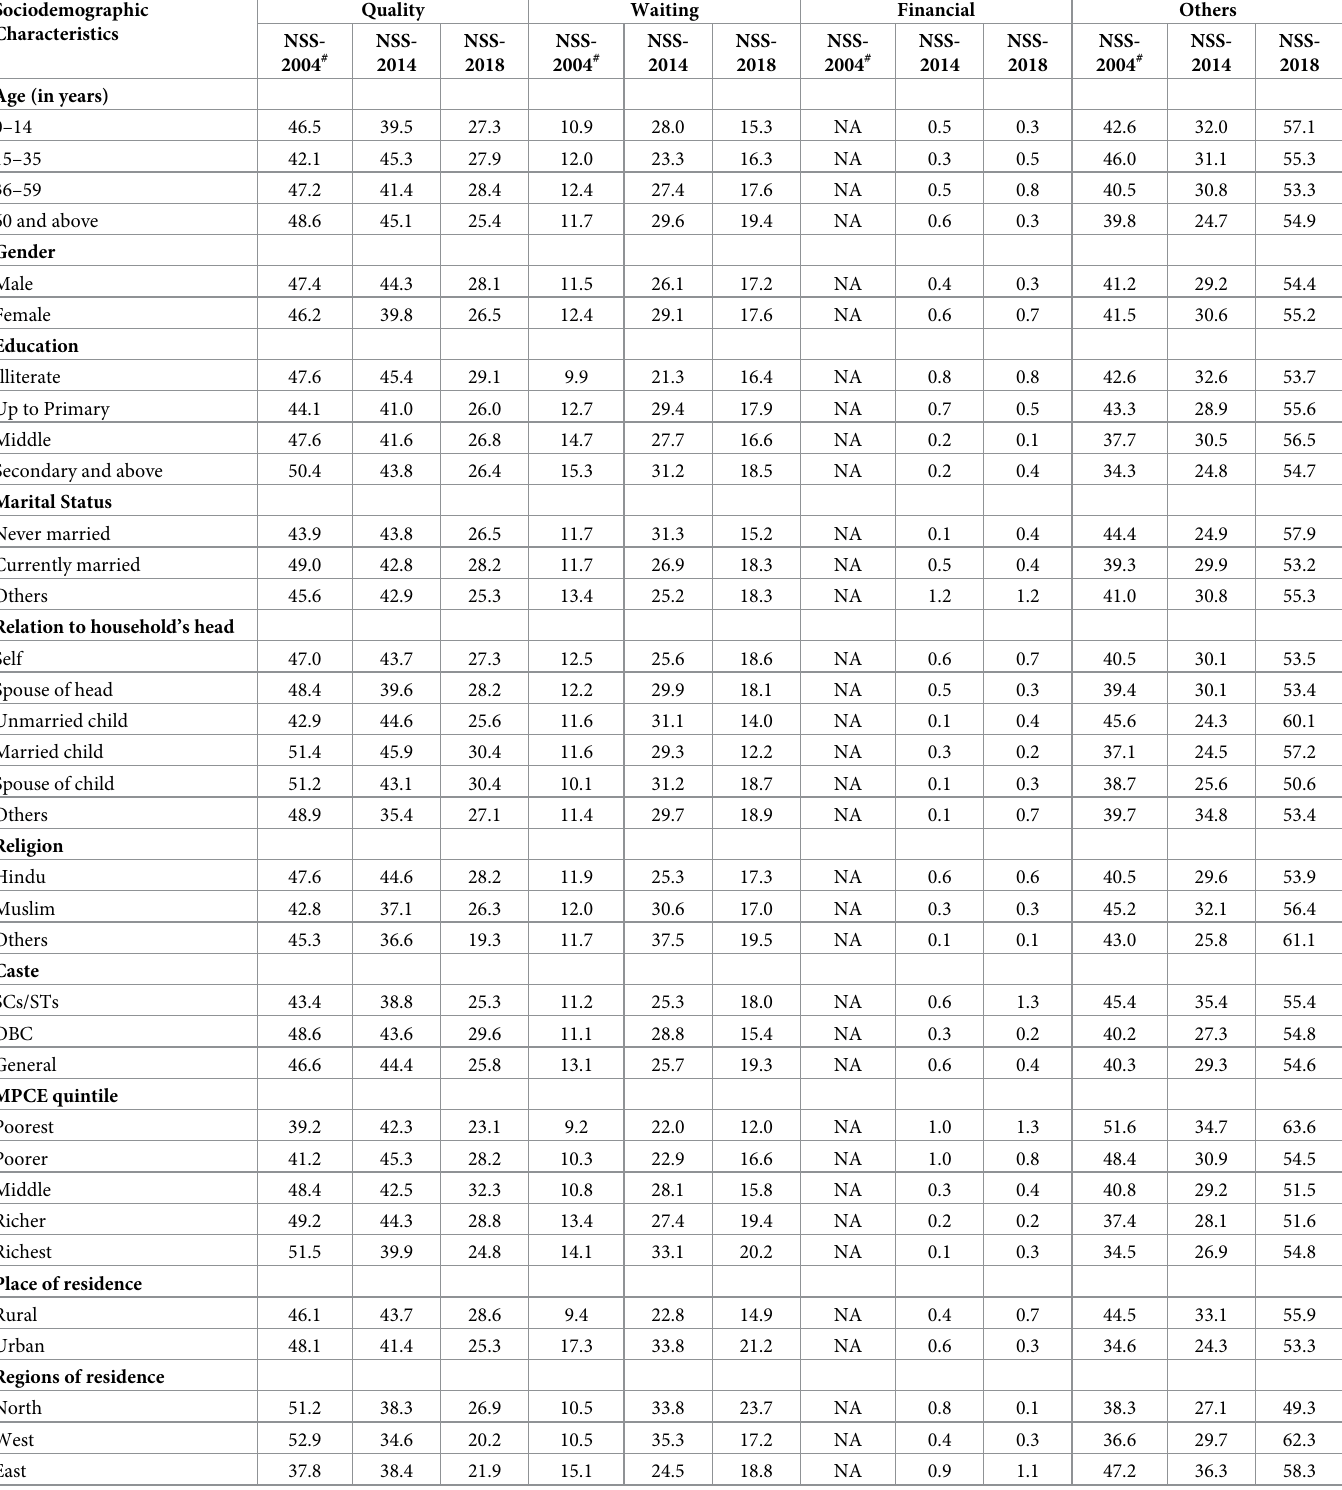
Table 6. Reasons for unmet need for treatment-seeking from public health facilities by sociodemographic characteristics, India, NSS, 2004–2018. Sociodemographic